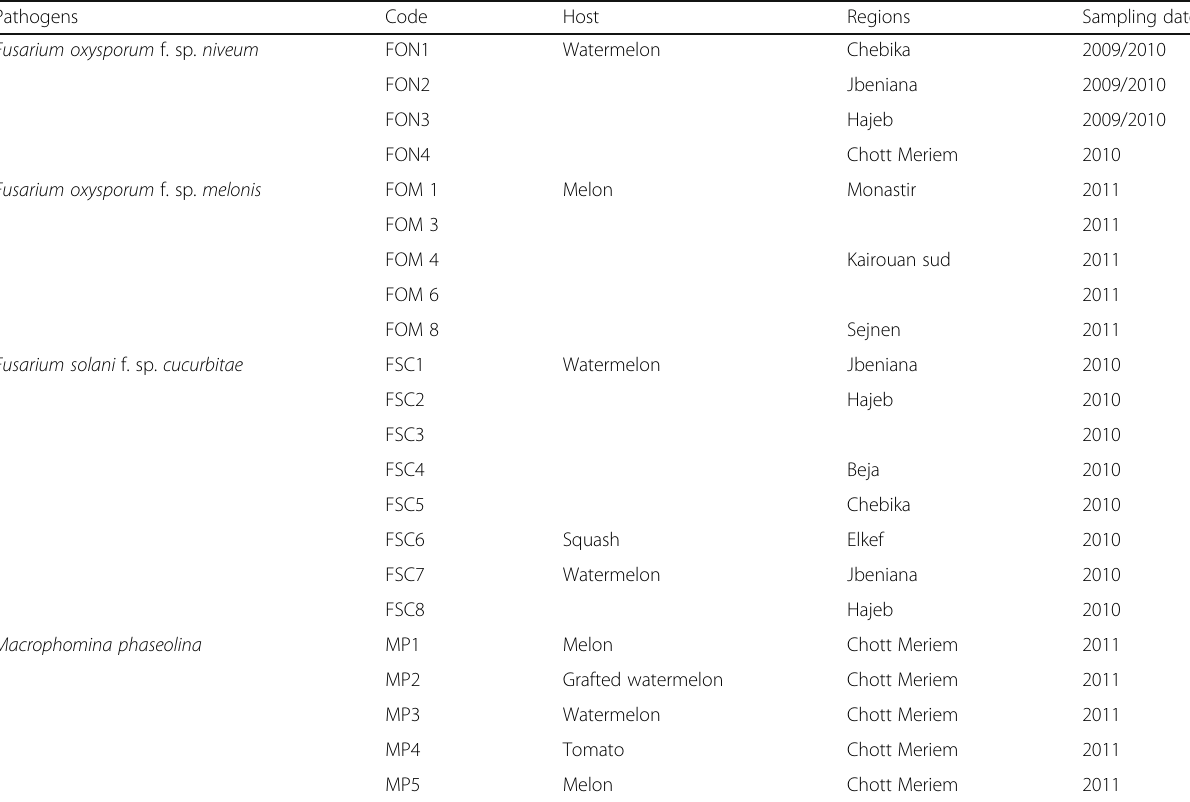
Table 1 Collection of 22 soil-borne pathogens isolates cucurbit plant host, regions, and date sampling. Four Fusarium oxy-